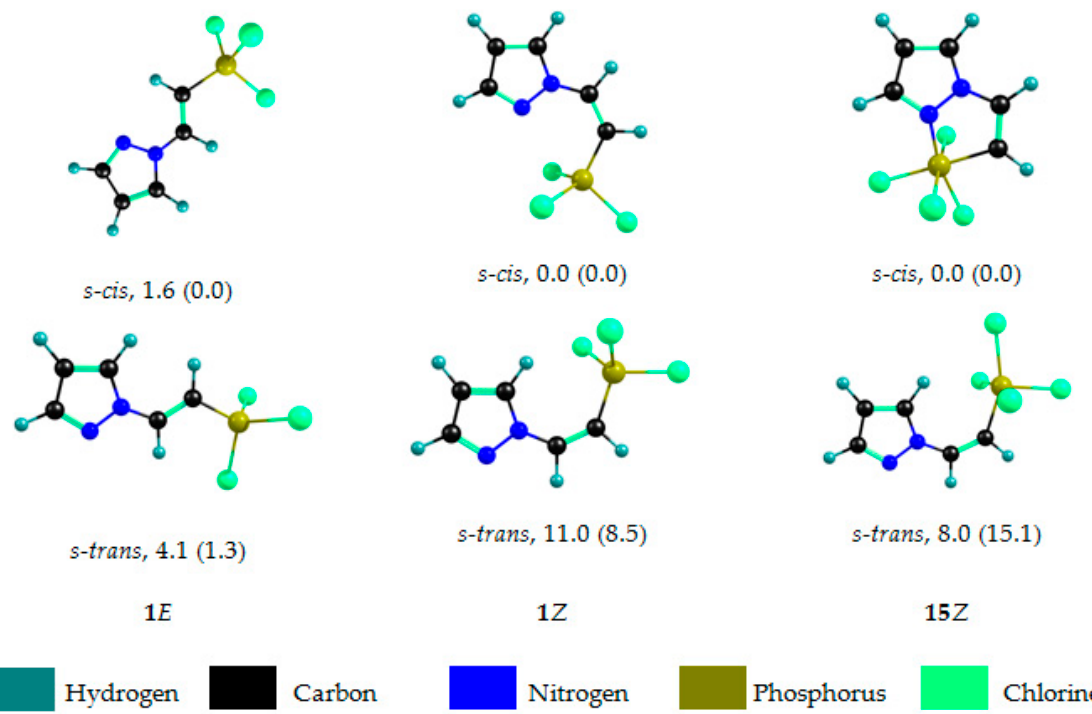
Figure 1. Predominant conformations and relative total energies (kcal/mol) of the s - cis and s - trans conformers of compounds 1 and 15 calculated by the B3LYP/6-311G(d,p) method for the gas phase and with taking into account the solvation effects within the polarizable continuum model (in pa- rentheses).